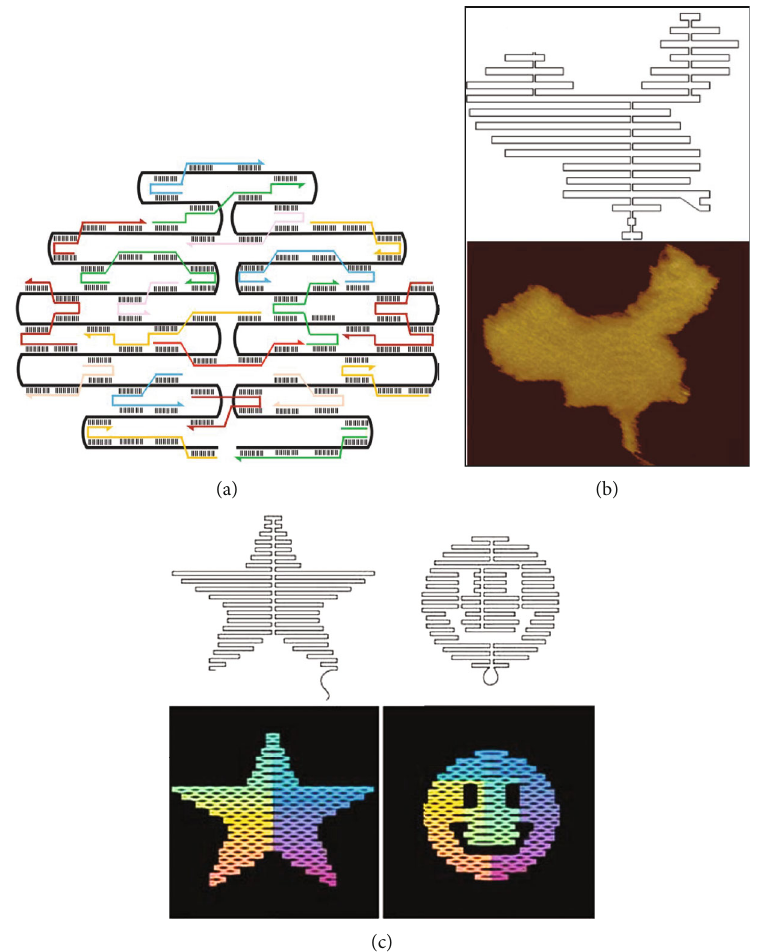
Figure 4: Principles of DNA origami (a) and two-dimensional AFM imaging structures including Chinese map (b), pentacle, and smiley face (c) [46,